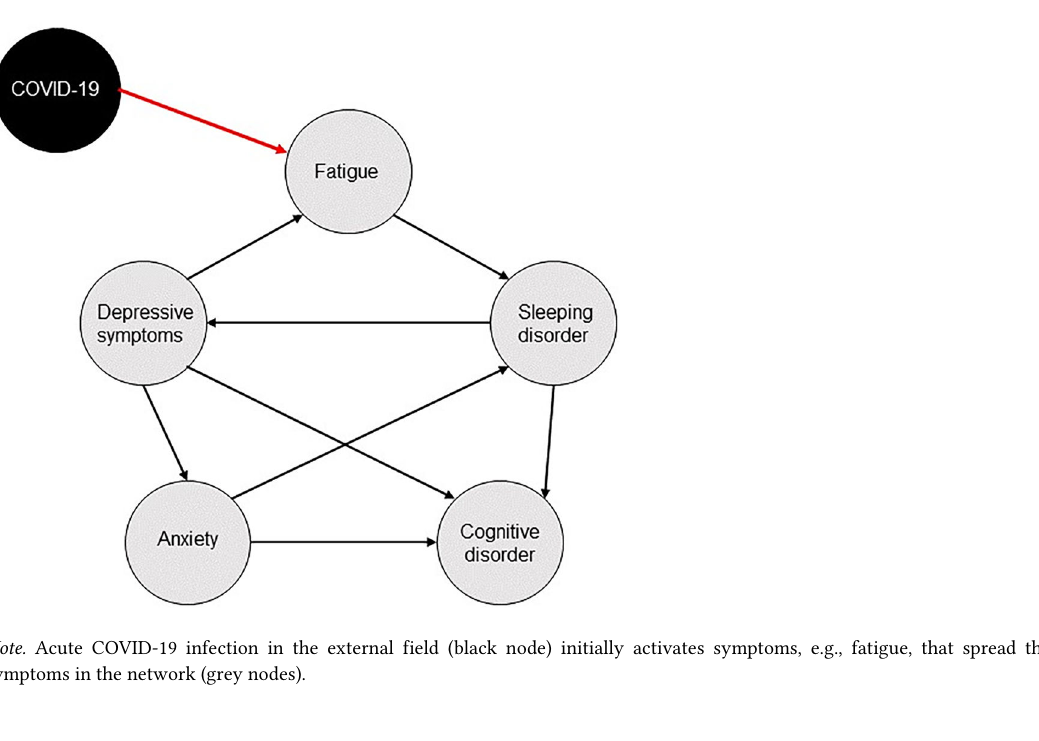
Possible Pathway of Activation in the Post-COVID Network of Neuropsychiatric and Cognitive Symptoms